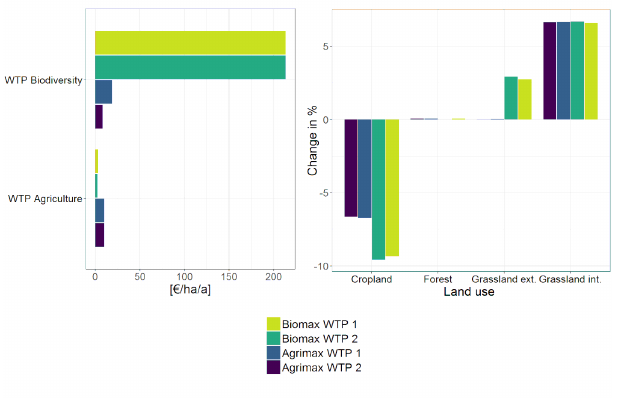
Fig. 6. Changes in willingness to pay (WTP; € ha −1 yr −1 ) and land use (%) compared to the status quo for the Pareto-optimal solutions with maximum WTP for agricultural production (Agrimax) and maximum WTP for biodiversity (Biomax) based on WTP functions 1 and 2,